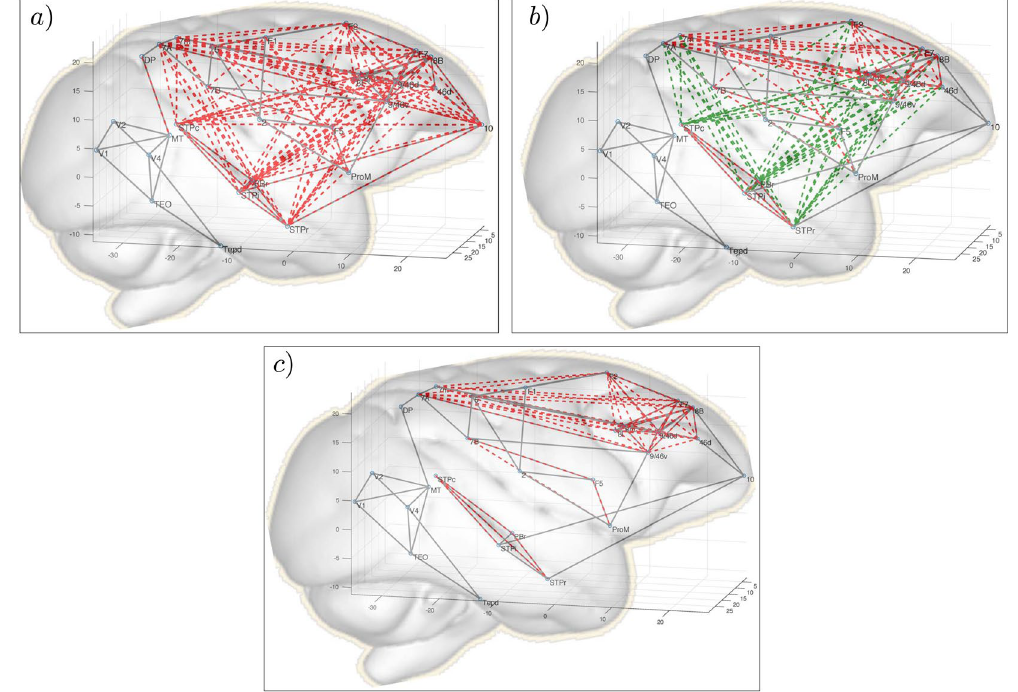
Figure 7. Simulation of the Macaque connectome. Structural links are shown with grey lines. Remote and direct synchrony links with > . r 0 75 are shown by dashed green and red lines, respectively. The parameters are ij ε = . 0 85 , δ π ν = D c 2 / , where ν = 40 Hz, c = 10 m/s and D ij is the internodal distance matrix taken from ref. 23. s ij ij s Frequencies are taken as inverse timescales for resting-state case from ref. 43. For ω = . 1/3 17 (panel a), node 10 10 is synchronous with a large cluster of nodes in the frontal and temporal cortices. When we increase the natural frequency of node 10 to its fast component ( ω = . 1/0 185 ), the hub becomes asynchronous while driving remote 10 synchronization of fronto-temporal regions (panel b). Increasing the frequency further ( ω = . 1/0 0625 ) frontal 10 and temporal regions become functionally disconnected (panel